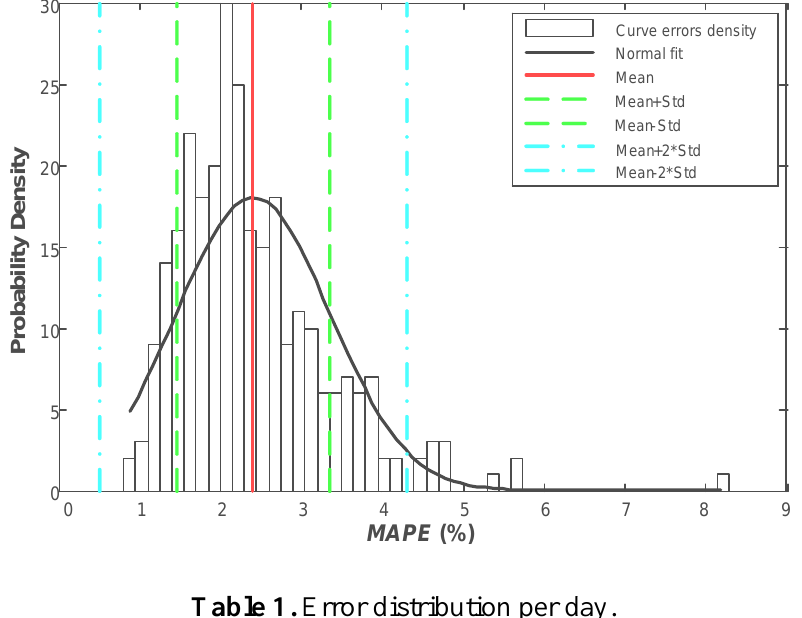
Figure 8. Curve errors data. In the x-axis are the errors by Equation (1). In the y-axis are the probability densities.